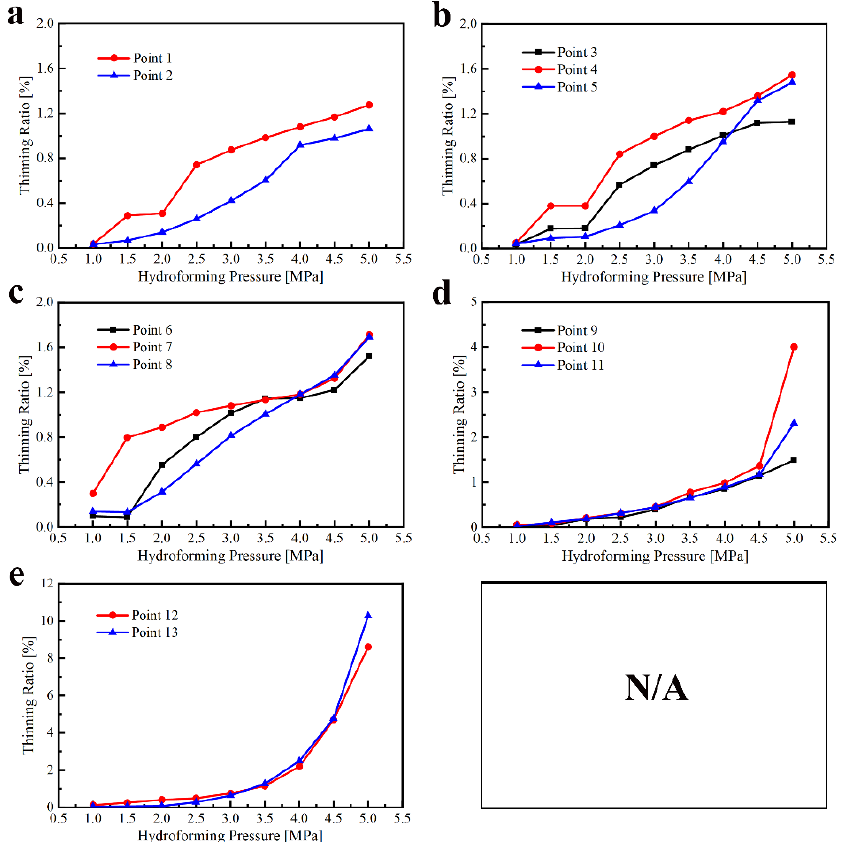
Figure 7. ( a – e ) Thicknesses thinning ratio of toroidal pressure hulls under various hydroforming pres- sures.